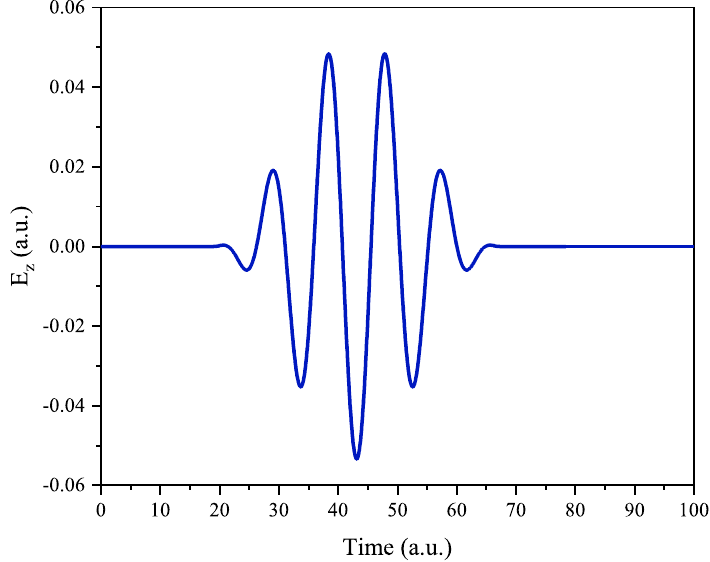
Figure 1. Potential energy curve of the ground state and the first excited state of H + employing the new dynamic nucleus (DN) approach. DN results are compared to the static nucleus (SN) approach results [32] (which are adopted with permission from the Journal of Computational Chemistry, published by John Wiley and Sons, 2018) and to the exact values [39] (which are adopted with permission from Atomic Data and Nuclear Data Tables, published by Elsevier, 1970.)